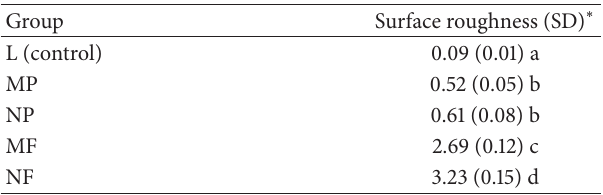
Table 3: Mean surface roughness